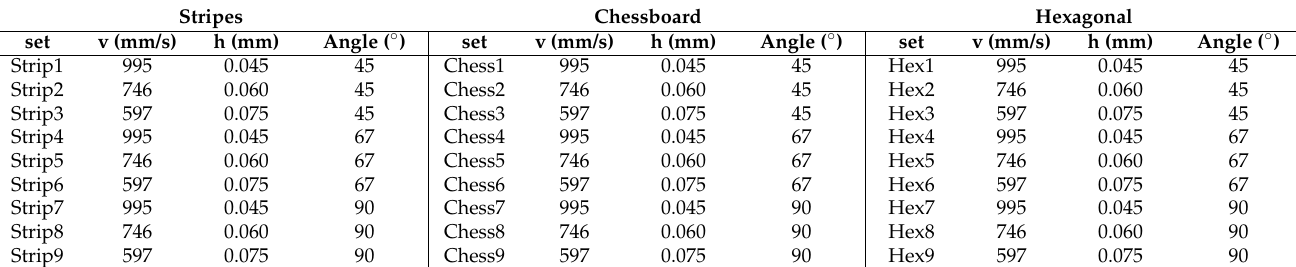
Figure 3. ( a ) Shape and dimensions (mm) of L-PBF specimens of prints 1, 2 and 3; ( b ) Graphical representation of the support structure. Table 3. Process parameters combinations used for prints 1, 2, and